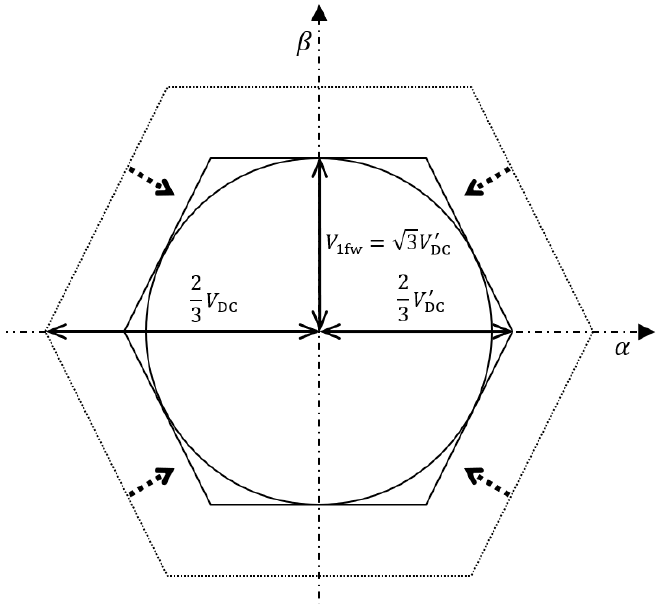
Figure 3. Relationship between the trajectory of the fundamental voltage wave vector and inverter DC-link voltage.